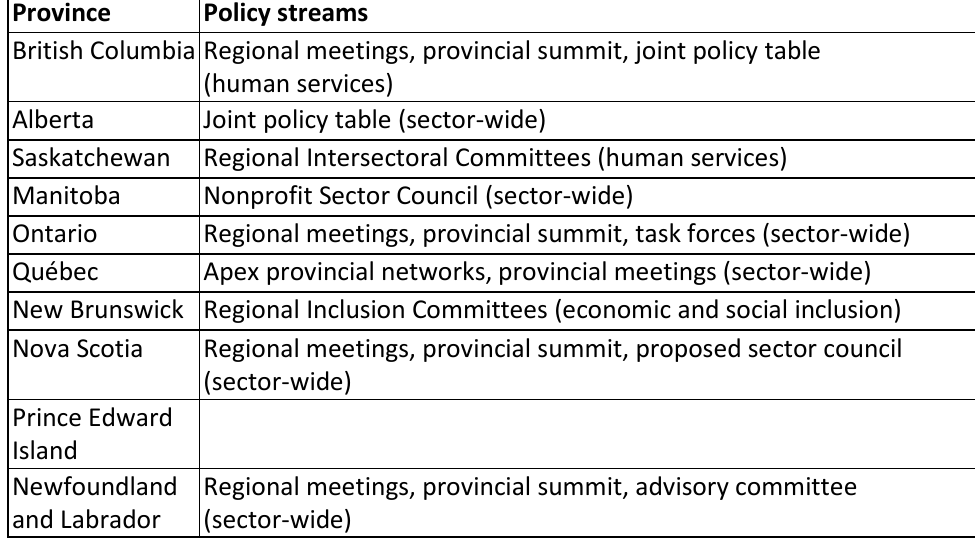
Table 3: Provincial Voluntary Sector-Government Policy Streams